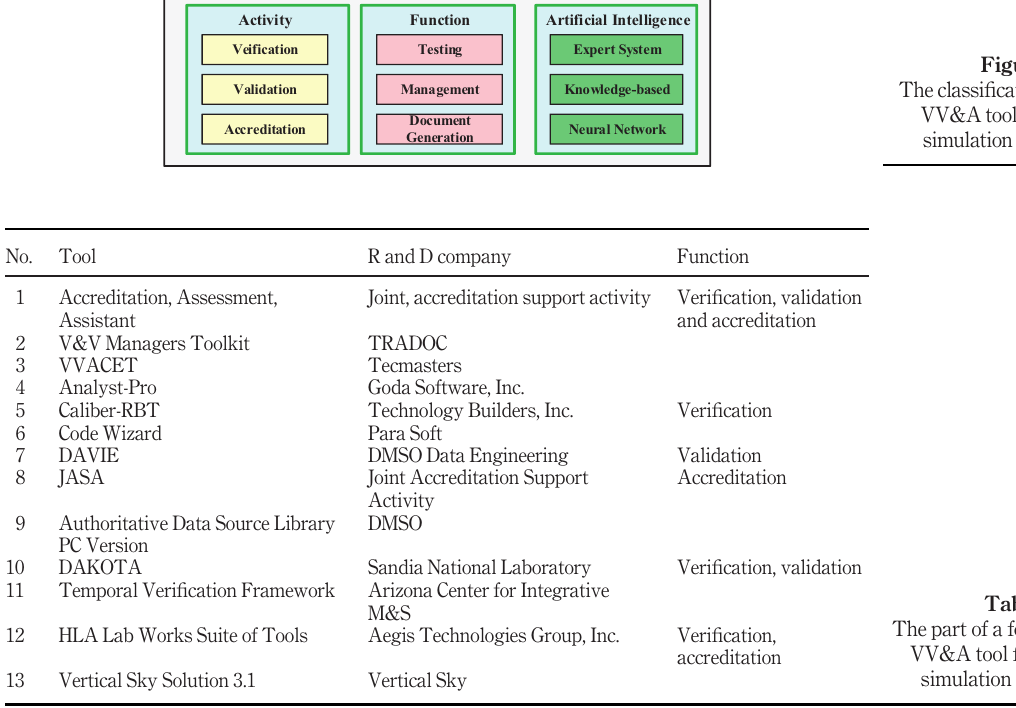
Table V. The part of a foreign